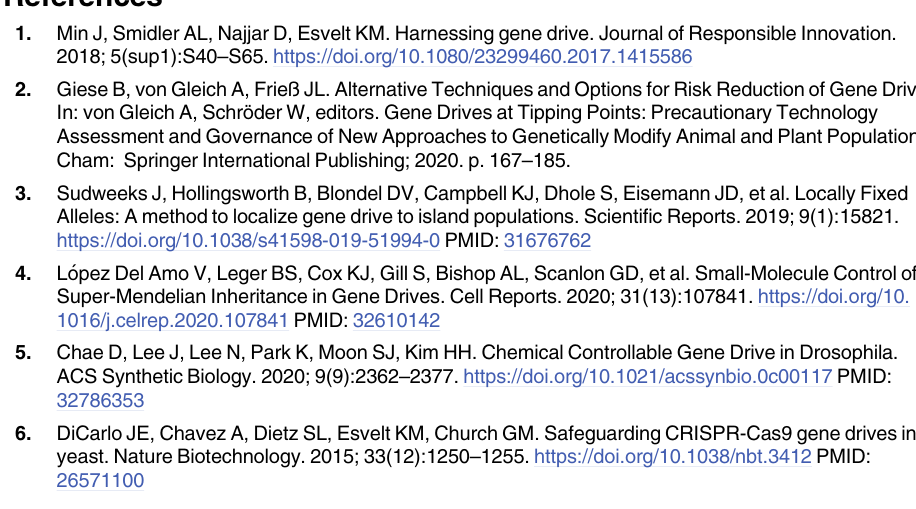
S18 Fig. Simultaneous changes to the maternal deposition cut-rate and male drive carrier frequency at release. Row 1 (a-c) . Maximum D allele frequency in population two. Row 2 A (d-f) . Maximum 1 allele frequency in population one. Row 3 (g-i) . Maximum 1 allele fre- A A quency in population two. The maximum frequency of D in population one and the differ- A ence between population one and two is shown in Fig 4. HDR does not occur with deposition- mediated cutting, and all cuts result in resistance mutations following the 1:9 ratio of type-1 to type-2.